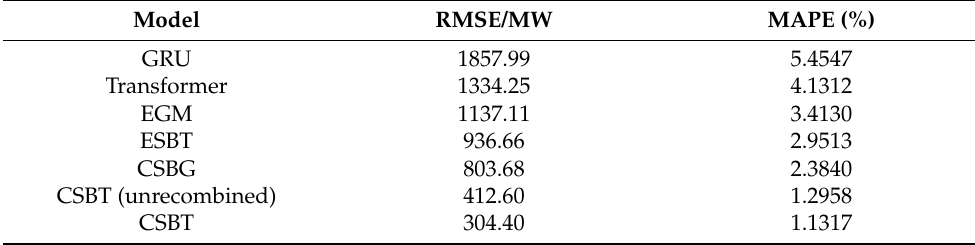
Table 5. Comparison of forecasting errors of each